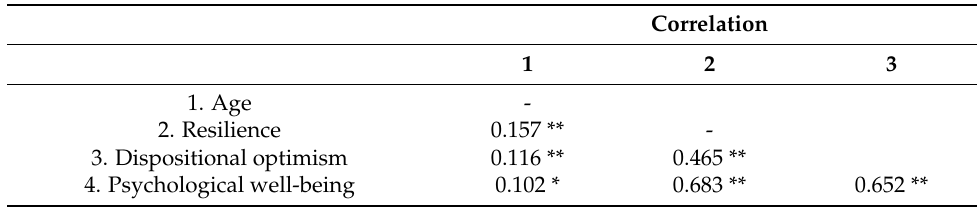
Table 3. The correlations between dispositional optimism, resilience, psychological well-being, and age. Correlation 1 2 3 1. Age - 2. Resilience 0.157 ** - 3. Dispositional optimism 0.116 ** 0.465 ** 4. Psychological well-being 0.102 * 0.683 ** 0.652 **